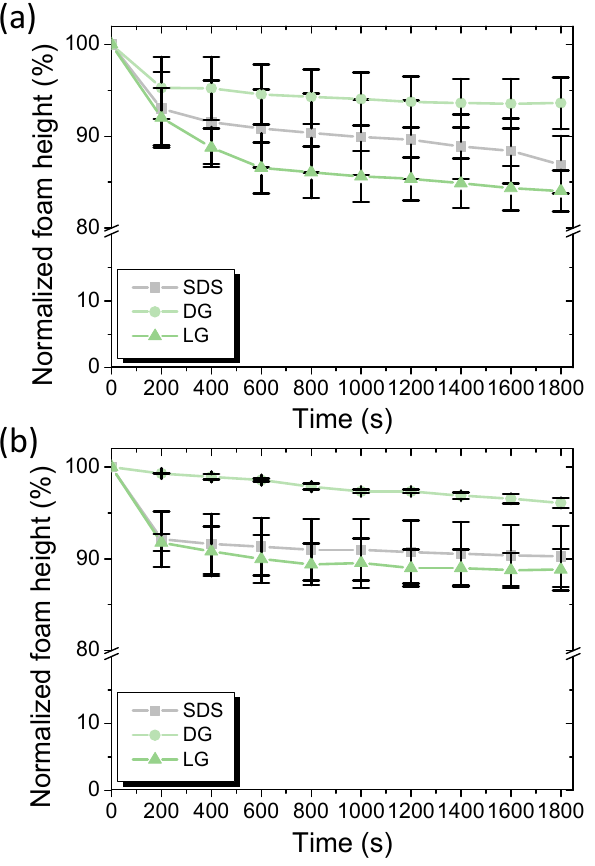
Figure 4. Evolution of the foam height for SDS, DG, and LG: ( a ) before the foam passed through the duct containing the plate contaminated with spores and ( b ) after the foam passed through the duct.